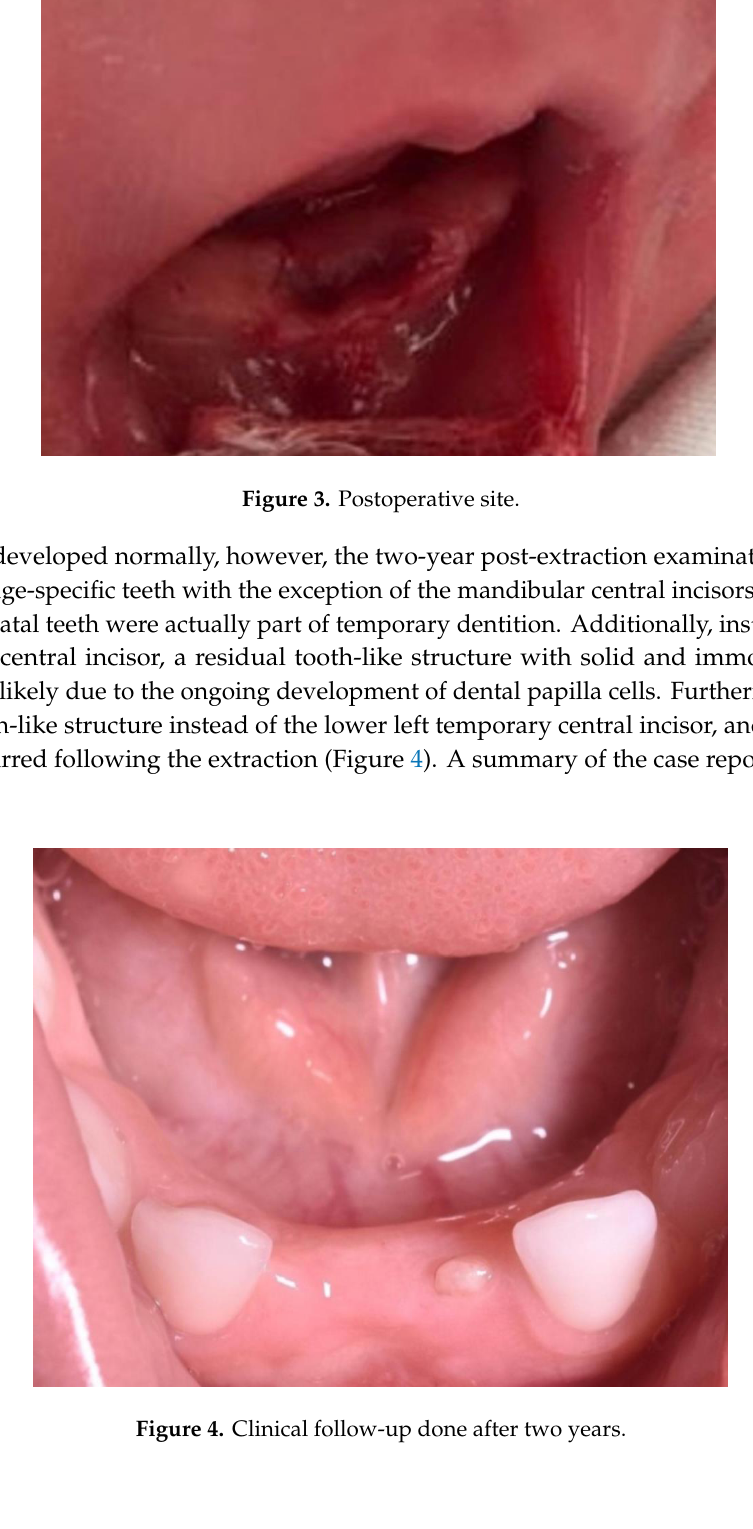
Figure 2. Extracted natal teeth.